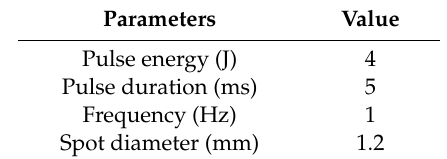
Table 3. Laser remelting parameters.